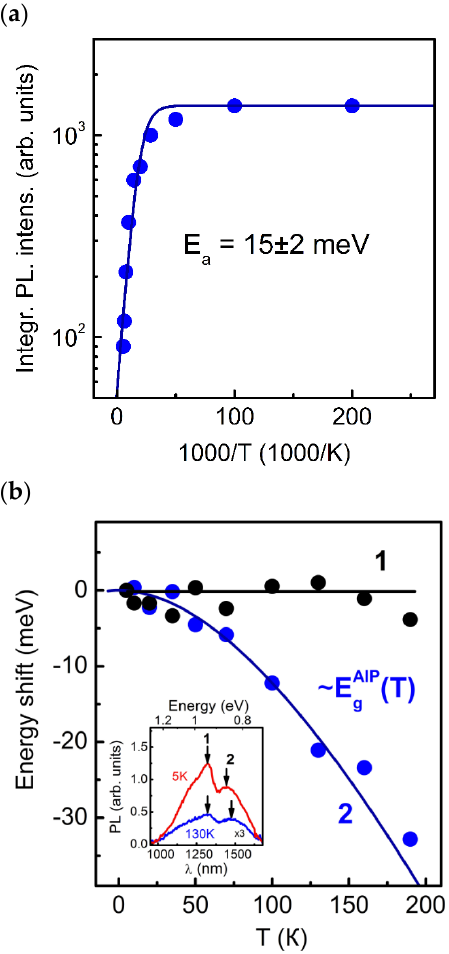
Figure 7. ( a ) Dependence of the integral SAQDs PL intensity on the temperature. The measurements were carried out at P ex = 25 W/cm 2 . The temperature quenching of PL is described by the Arrhenius function with the activation energy of 15 ± 2 meV. ( b ) Temperature dependences of the energy shift in the PL bands with the maxima at 0.95 eV (1) and 0.86 eV (2). The solid lines show the functional approximation experimental data. The PL spectra of HS D measured at 5 and 130 K are shown in the inset. The arrows and numbers 1 and 2 indicate the positions of the maxima of the PL bands associated with the defects in AlP and SAQDs, respectively.